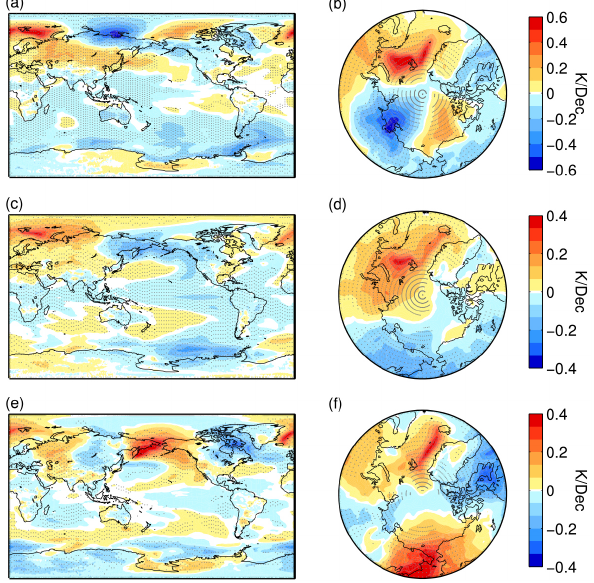
Fig. 3. Linear trends in surface air temperature for the period 1975– 2005 over the globe and Arctic due to changes in all aerosols ( a and b ), sulfate only ( c and d ) and black carbon only ( e and f ), respec- tively. Gray dots indicate trends that are statistically significant at the 95% level ( p < 0 . 05) based on an F